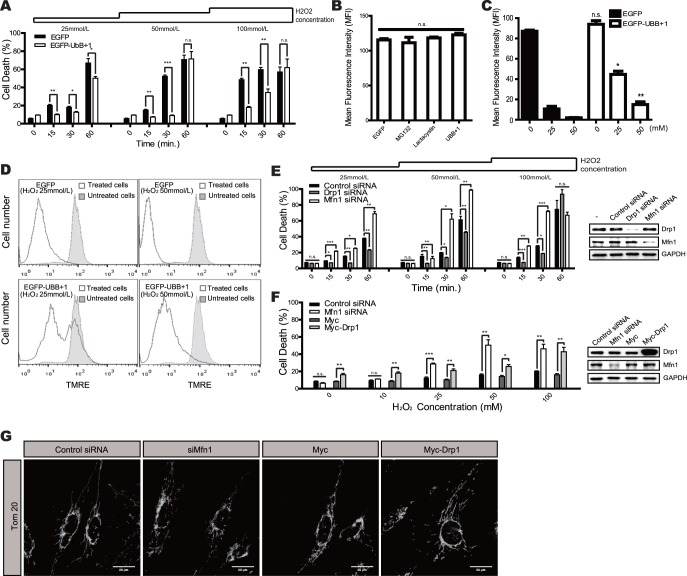
Effects of UBB+1 on oxidative stress-induced cell death.
A, CRT-MG cells stably expressing pEGFP and pEGFP-UBB+1 were incubated in the absence or presence of H2O2 (0–100 mmol/L) for different time periods as indicated (0–60 min). After stimulation, cell death was assessed using an LDH assay. Data are presented as the mean ± SEM (n = 3), and Turkey’s post hoc test was applied to significant group effects (p<0.0001) identified by ANOVA. Asterisks indicate a significant difference compared with the control: *p<0.05, **p<0.01, ***p<0.001. B, Cells were stained with TMRE, and the mean fluorescence intensity was determined using FACS analysis. The graph represents the mitochondrial membrane potential Δψ. Data are presented as the mean ± SEM (n = 3), and Turkey’s post hoc test was applied to significant group effects identified by ANOVA. C, The mean fluorescence intensity of TMRE staining was assessed after treatment with H2O2, and the graph represents the mitochondrial membrane potential Δψ. Data are presented as the mean ± SEM (n = 3), and Turkey’s post hoc test was applied to significant group effects identified by ANOVA. Asterisks indicate a significant difference between UBB+1-expressing and control cells. D, CRT-MG cells stably expressing pEGFP or pEGFP-UBB+1 were treated with 25 or 50 mmol/L H2O2 for 15 min, and mitochondrial membrane potential was assessed using TMRE. Filled, untreated cells; lined, treated cells. E, CRT-MG cells stably expressing EGFP were transfected with siRNA against Drp1, Mfn1, or the negative control, and stimulated with 0–100 mmol/L H2O2 for 0–60 min as indicated. Efficient knockdown of Drp1 and Mfn1 was confirmed by Western blotting. F, CRT-MG cells stably expressing UBB+1 were transfected with Mfn1 siRNA, control siRNA, Drp1-overexpressing pCMV-Myc or pCMV-Myc. Cells were then stimulated with 0–100 mmol/L H2O2 for 30 min. Efficient knockdown of Mfn1 and overexpression of Drp1 were confirmed by Western blotting. After treatment, cell death was assessed by an LDH assay. Data are presented as the mean ± SEM (n = 3); Turkey’s post hoc test was applied to significant group effects (p<0.0001) identified by ANOVA. Asterisks indicate a significant difference compared with the control: *p<0.05, **p<0.01, ***p<0.001. G, The mitochondrial morphology was analyzed after staining for Tom20 in UBB+1 expressing cells transfected with control siRNA, Mfn1 siRNA, Drp1-overexpressing pCMV-Myc or pCMV-Myc.